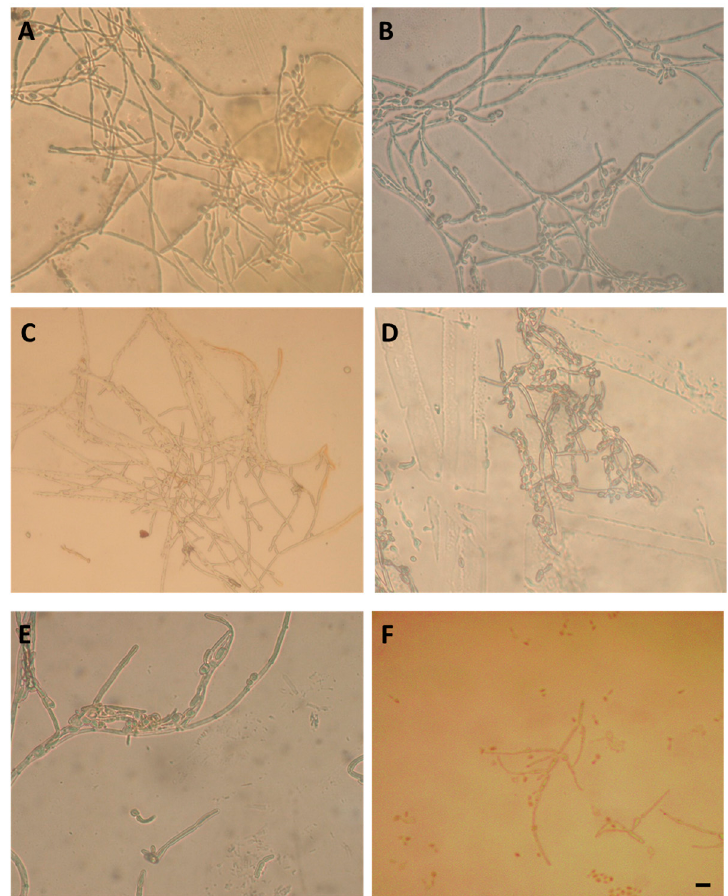
Figure 9. Inverted microscope images (400× magnification) of C. albicans SC5314 biofilms grown on different surfaces: ( A ) p(MSA- co -PTMSi5), ( B ) p(MSA- co -PTMSi1), ( C ) p(MPC- co -PTMSi5), ( D ) p(F6- co -PTMSi5), ( E ) p(F6- co -PTMSi1) and ( F ) glass (scale bar denotes 10 µm for all images).